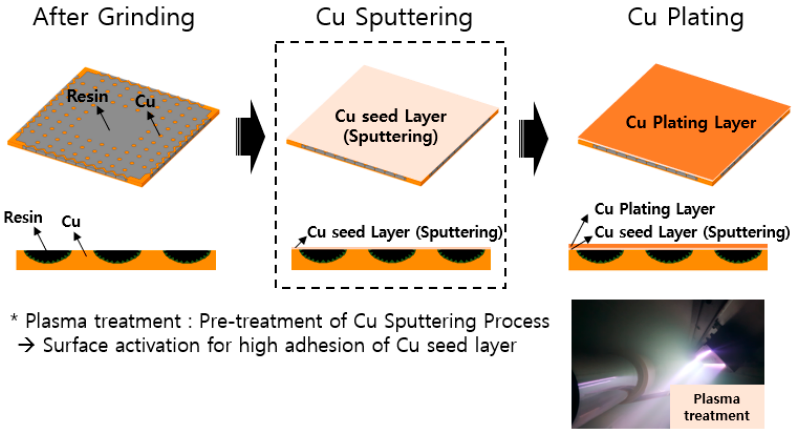
Figure 3. HDS Cu sputtering process w/ plasma pretreatment to secure high adhesion.